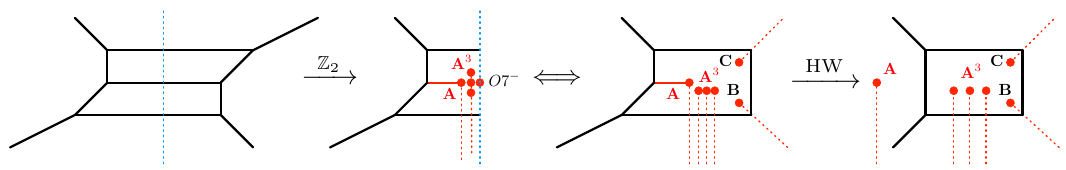
Figure 19 . The Z 2 quotient of 5d SU(3) 0 theory without flavor leading to SU(2) + 3 F . Here a free hypermultiplet associated with a 7-brane A outside of the 5-brane web is decoupled by Hanany-Witten (HW) moves.